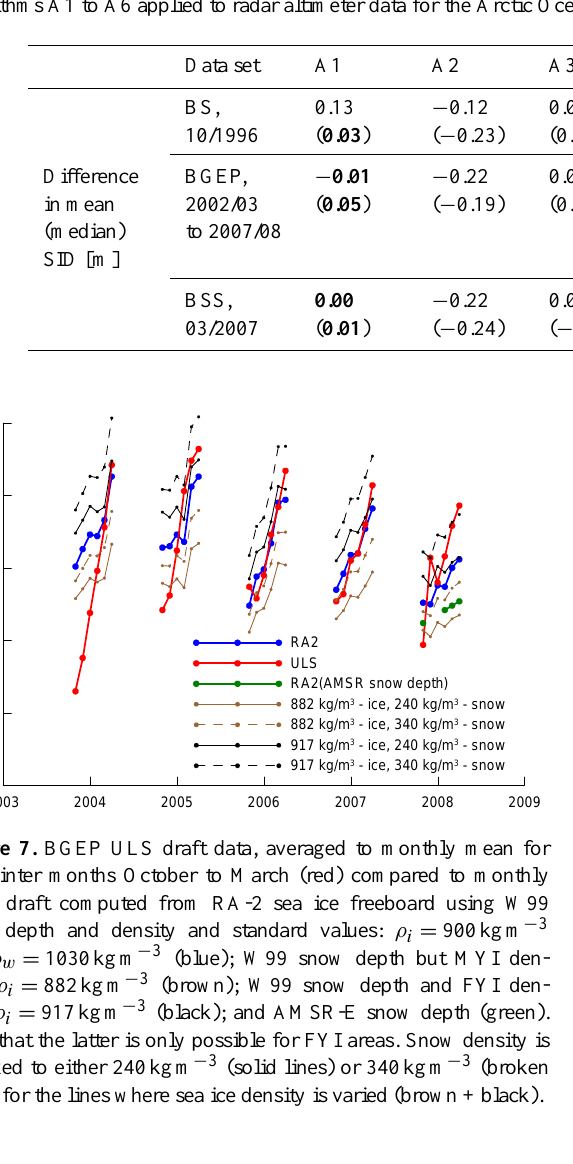
Table 5. Differences of mean and median observed minus computed sea ice draft from submarine and moored ULS (see Table 1) and algorithms A1 to A6 applied to radar altimeter data for the Arctic Ocean. Algorithms giving the smallest difference are highlighted in bold.